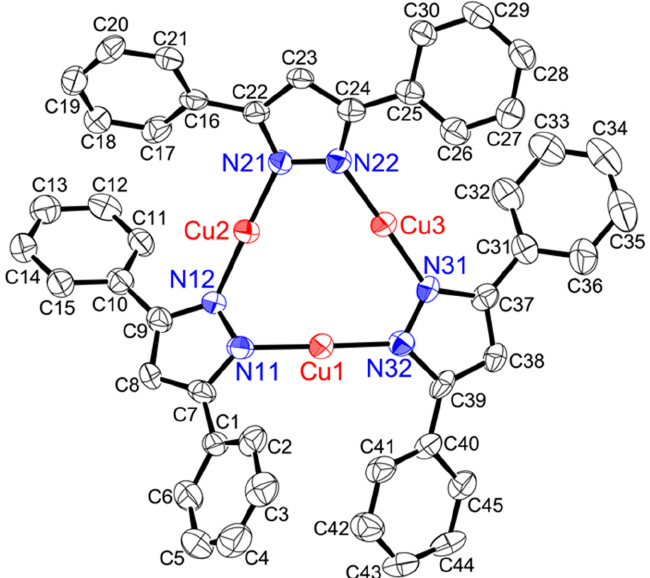
Figure 4. Crystal structure of [Cu( μ -L5pz)] 3 showing 50% displacement ellipsoids and the atom labeling scheme. Hydrogen atoms are omitted for clarity. Relevant bond lengths (Å) and angles (°):